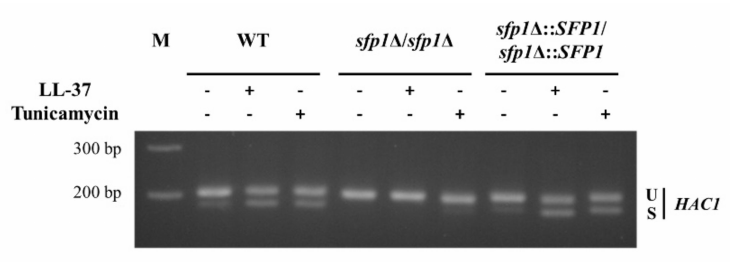
Figure 3. Detection of HAC1 mRNA splicing. Cells were treated with or without LL-37 (8 µ g/mL) or tunicamycin (5 µ g/mL) for 30 min. Total RNA was extracted, and RT–PCR was performed. U: unspliced HAC1 ; S: spliced HAC1 . The size difference between the unspliced and spliced cDNA is 19 bp. The data are representative of three independent experiments with identical results. M: DNA